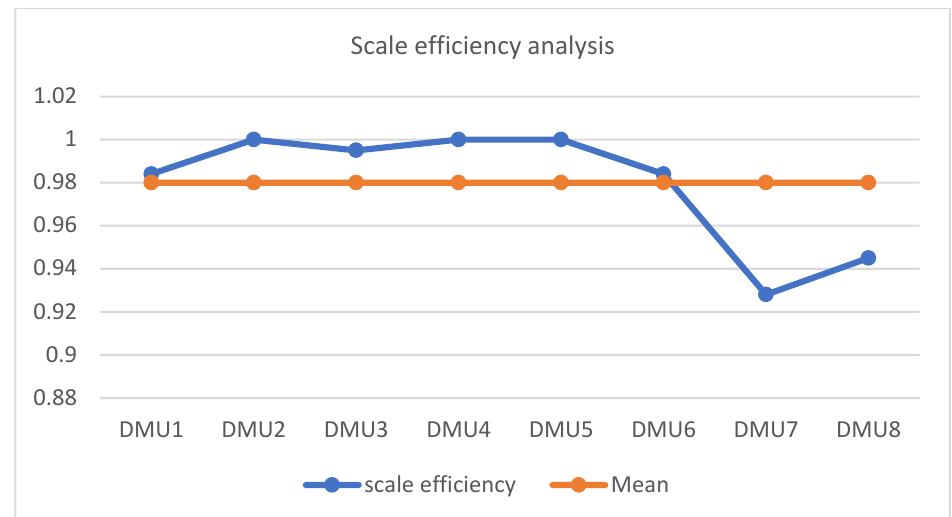
Figure 4. Comparative analysis of comprehensive technical efficiency.